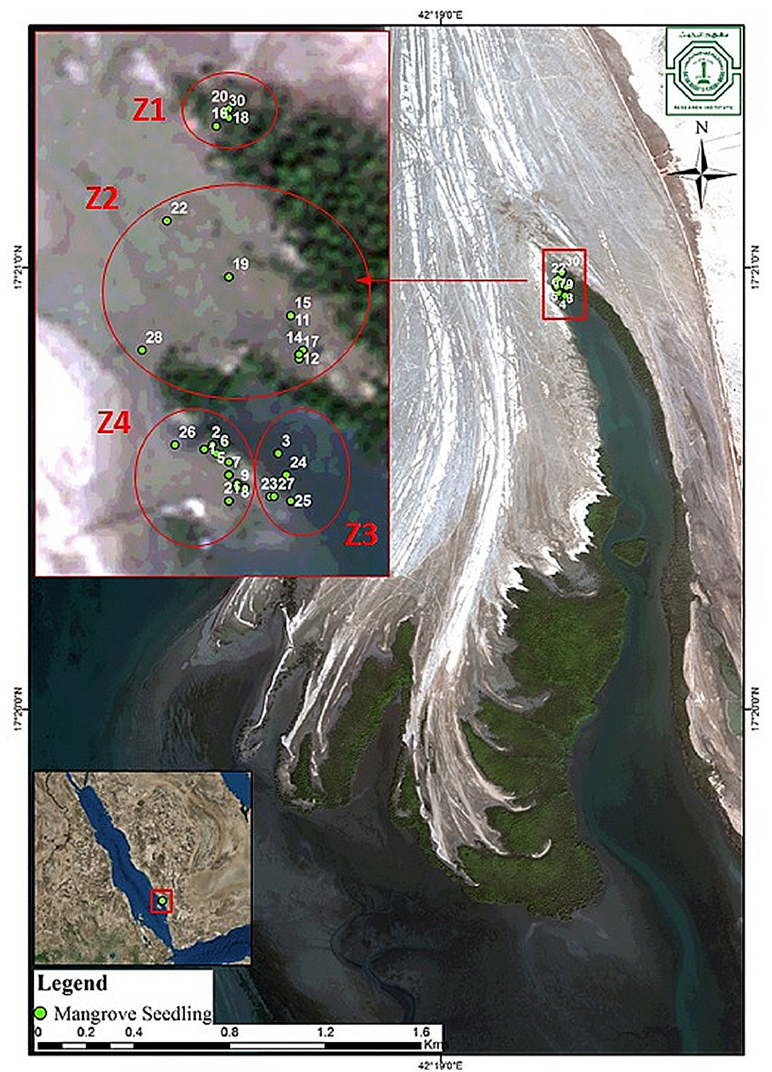
Fig. 1. – Location of the study site and seedlings assigned to four zones (rounded